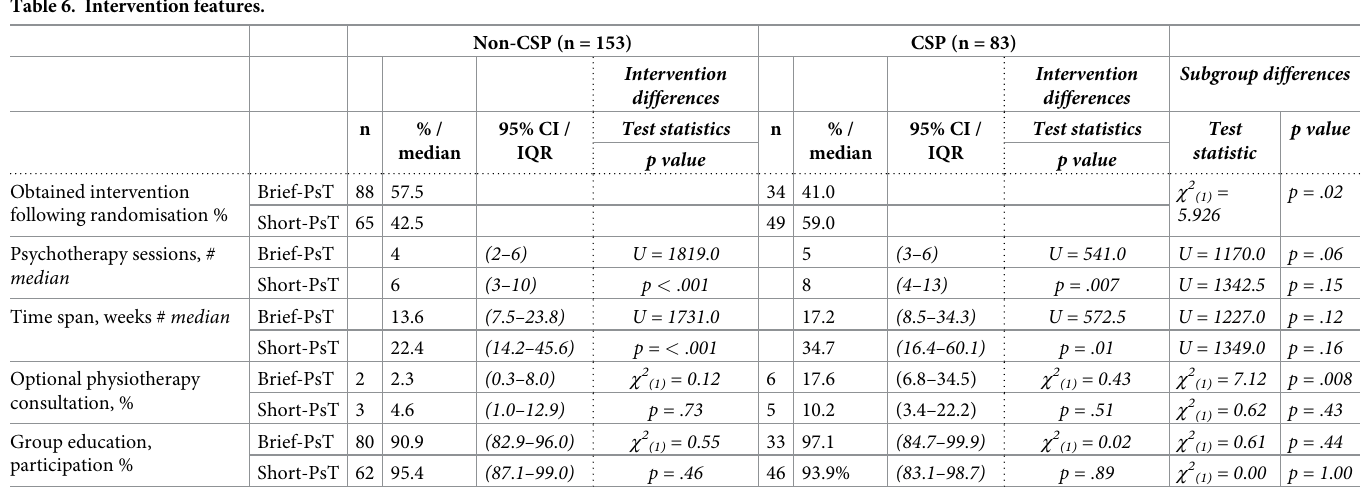
Table 6. Intervention